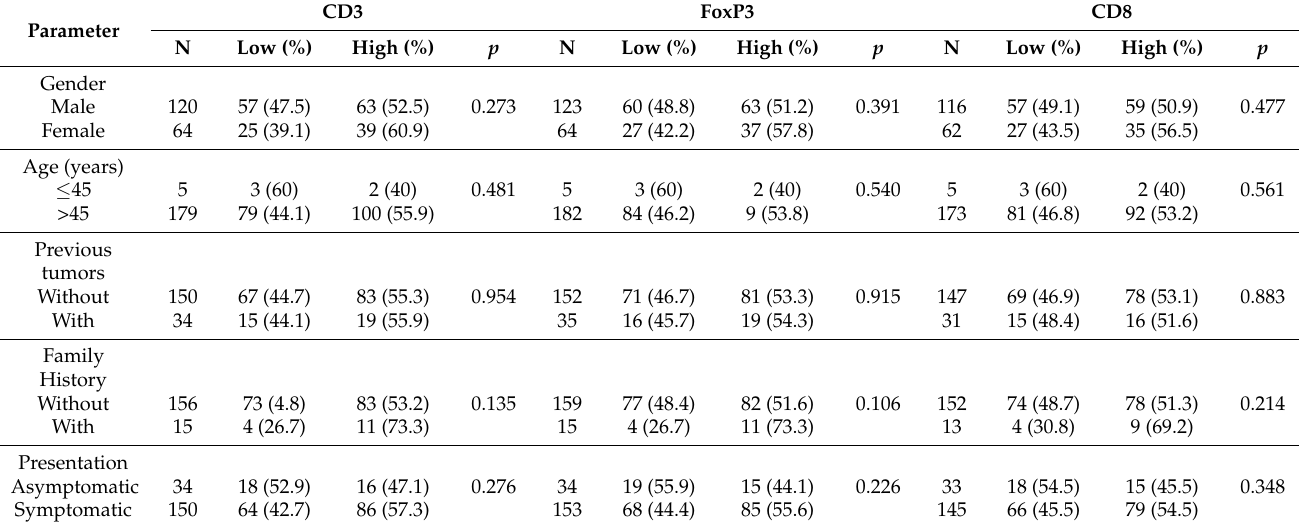
Table 4. Association of intratumor infiltration of CD3 + , FoxP3 + , and CD8 + T lymphocytes with clinical data.